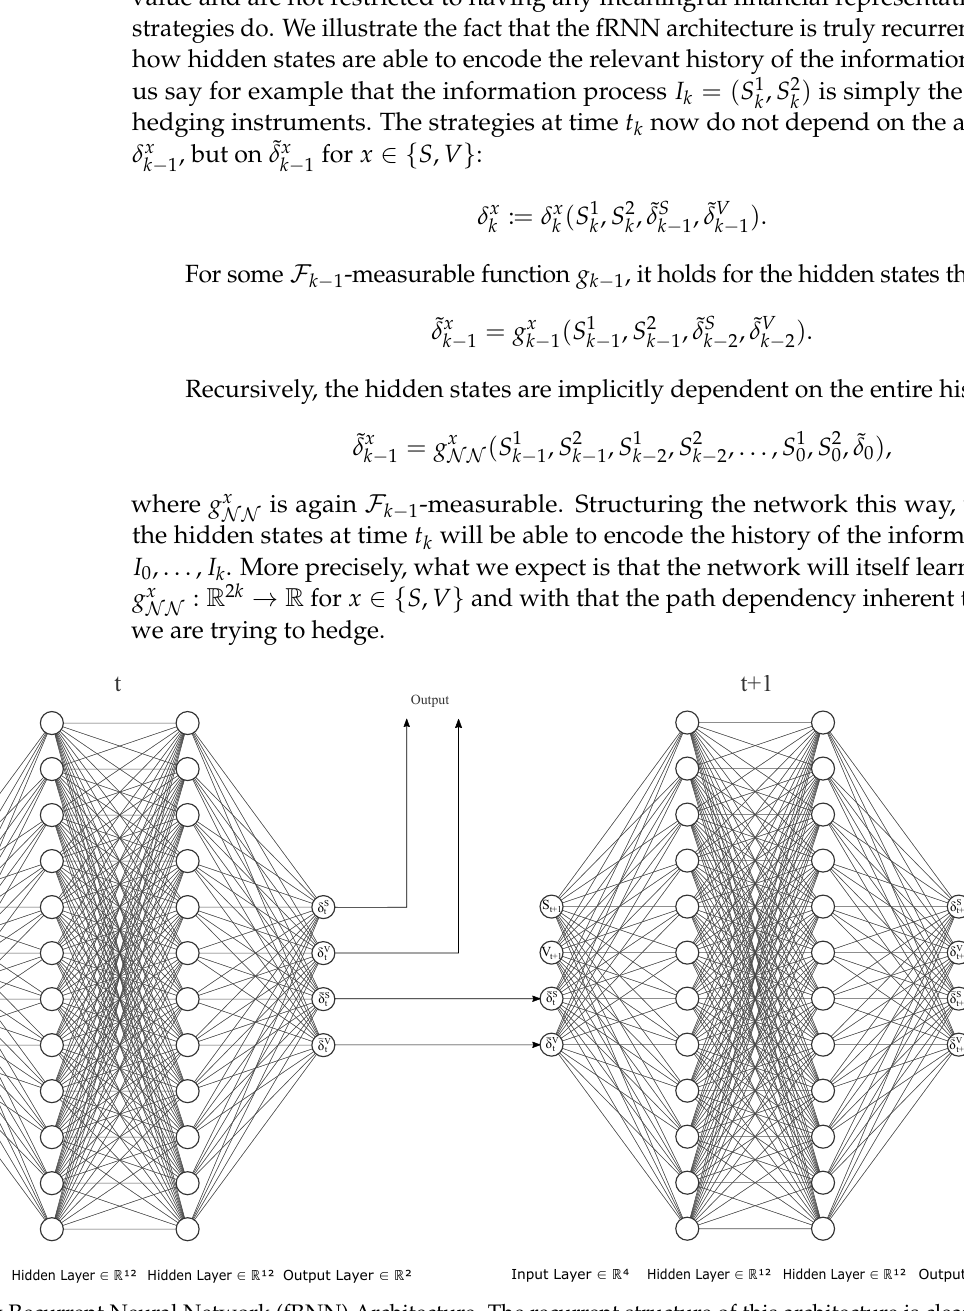
Figure 3. Fully Recurrent Neural Network (fRNN) Architecture. The recurrent structure of this architecture is clearly visible as hidden states are passed on to the next cell at each time